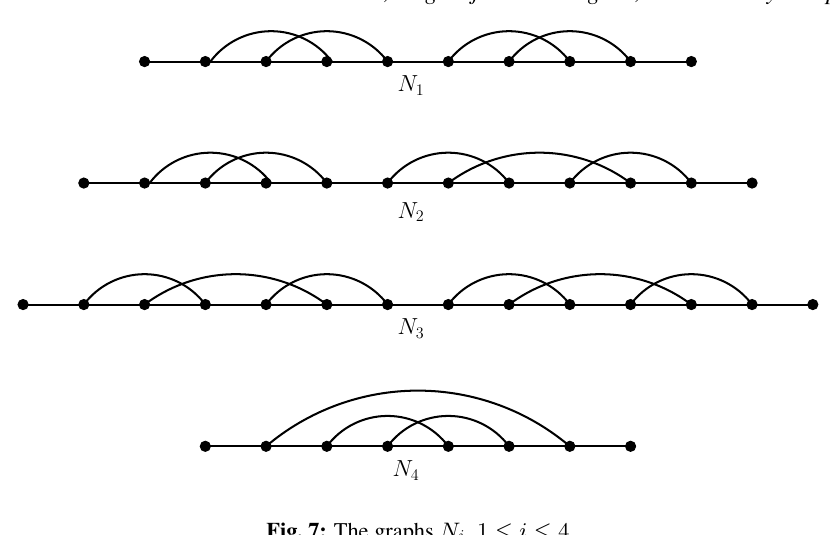
Fig. 7: The graphs N i , 1 ≤ i ≤